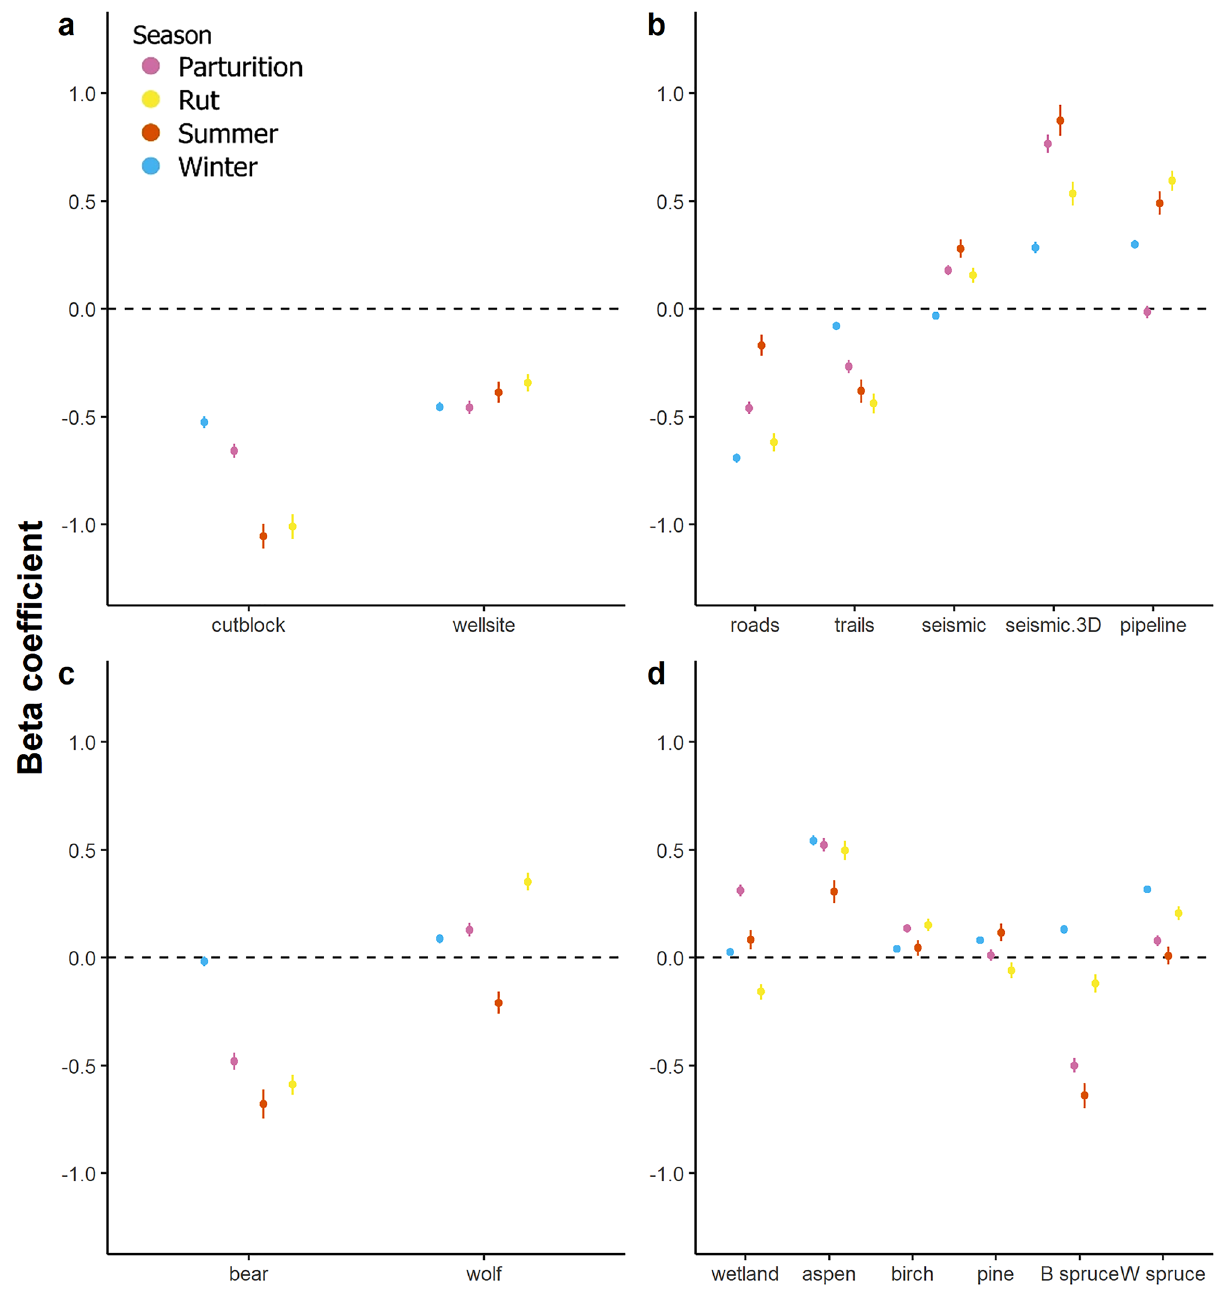
Figure 4. Beta coefficient estimates and 95% confidence intervals from Generalized Linear Mixed-effect Models (GLMMs) for ( a ) polygonal features ( b ) linear features, ( c ) predation risk and ( d ) natural habitat features, for each season: winter, parturition (red), summer (green) and rut (orange). In panels a, b, and c where variables are a measure of distance, negative beta values represent selection and positive values represent avoidance to a feature. Vegetation and predator variables are interpreted as positive for selection and negative for